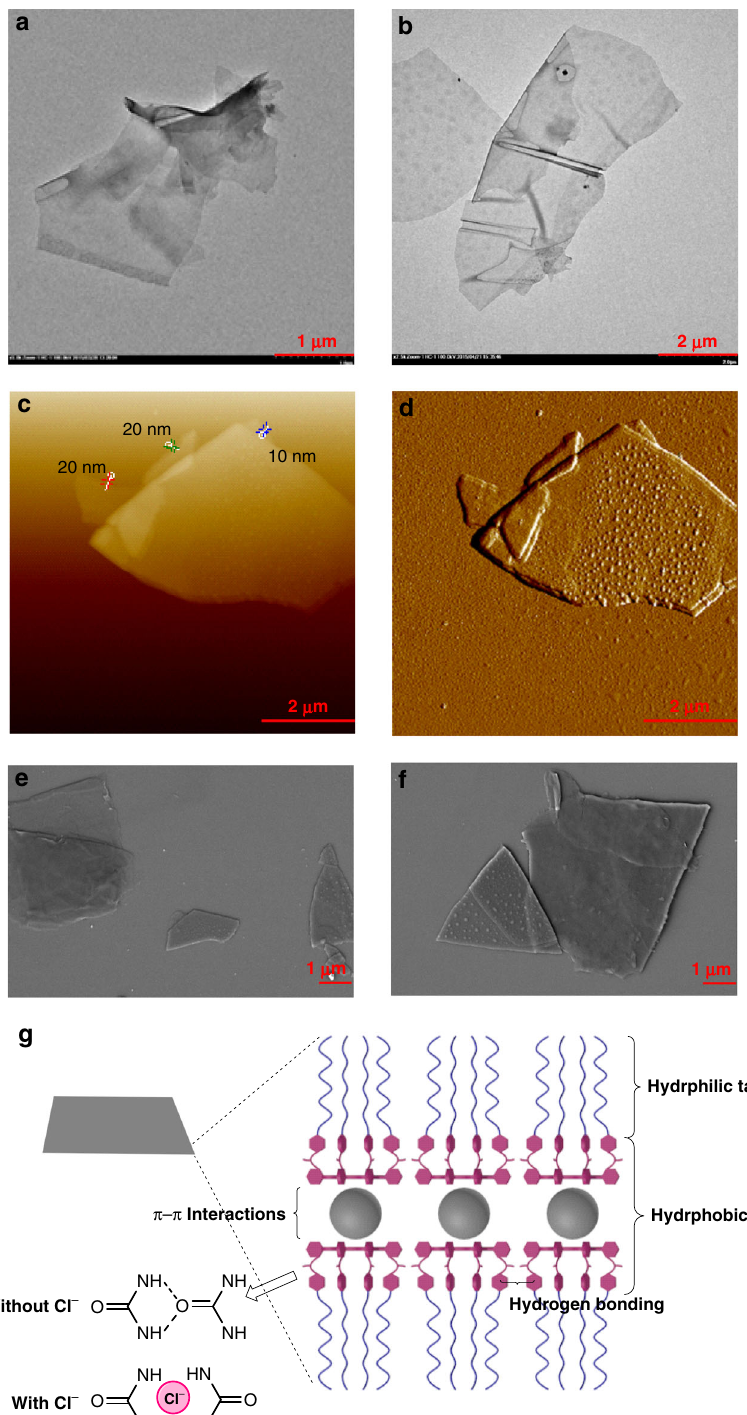
Fig. 6 Electron microscope images of self-assemblies formed from 5 2 (cid:129) 8 . a TEM image of 5 2 (cid:129) 8 (1.00 × 10 − 4 M) in aqueous solution. b TEM image of 5 2 (cid:129) 8 (1.00 × 10 − 4 M) with the addition of 4 equiv n -Bu 4 NCl in aqueous solution. c , d AFM images of 5 2 (cid:129) 8 (1.00 × 10 − 3 M) with the addition of 4 equiv n -Bu 4 NCl in aqueous solution. e SEM image of 5 2 (cid:129) 8 (1.00× 10 − 4 M) in aqueous solution. f SEM image of 5 2 (cid:129) 8 (1.00 × 10 − 4 M) with the addition of 4 equiv n -Bu 4 NCl in aqueous solution. g Schematic representation of the self-assembly of 5 2 (cid:129)